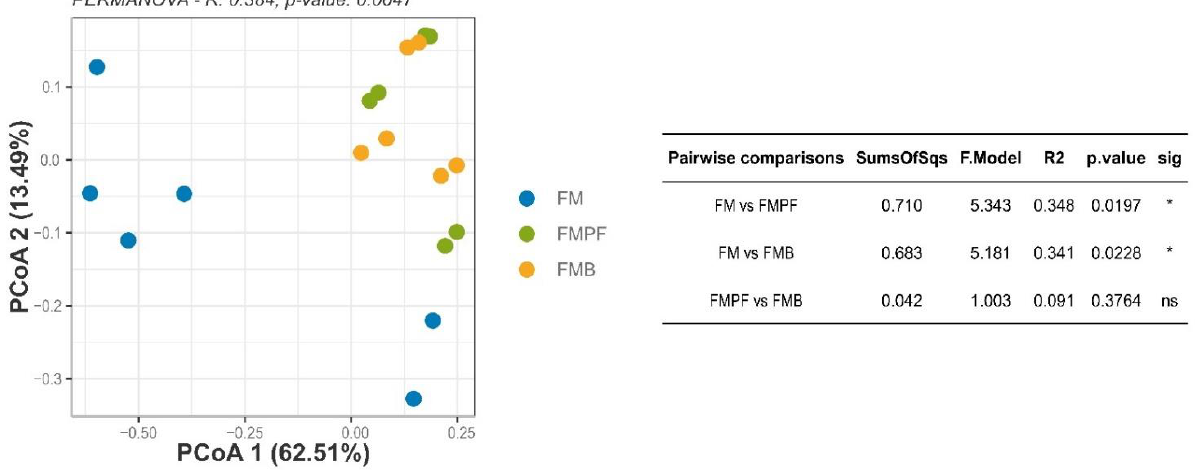
Figure 4. Principal coordinate analysis (PCoA) of Bray – Curtis dissimilarities distances. The aggre- gated table (right) shows which sample groups differed according to the significance observed by the PERMANOVA post-hoc test. * p ≤ 0.05.